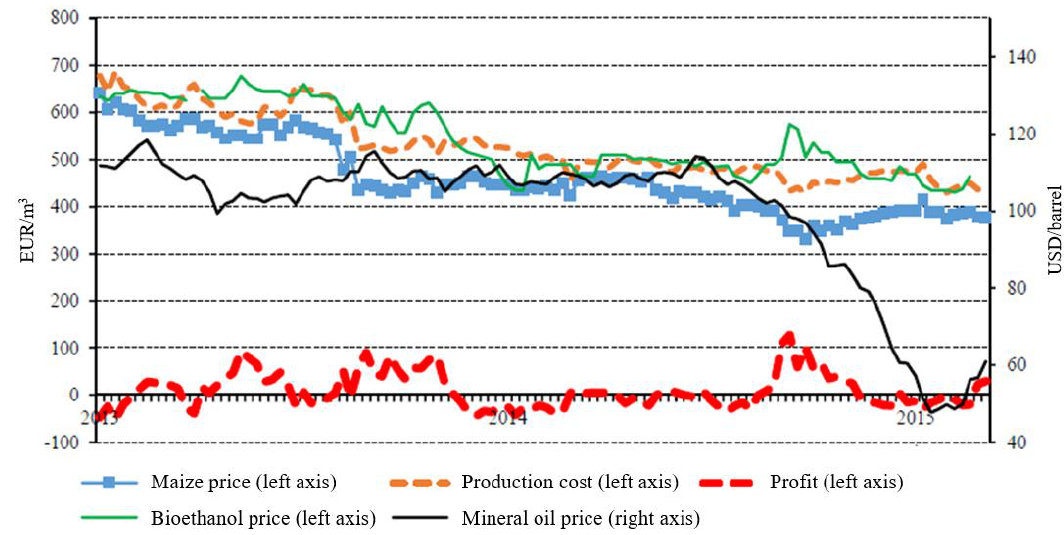
Figure 1. Connections between the major factors of the ethanol price. Source: [19].